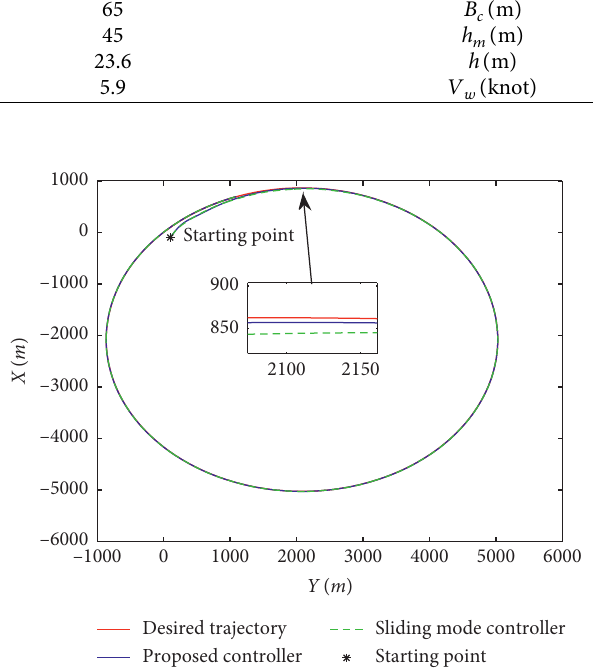
Figure 2: The actual and desired trajectory of the